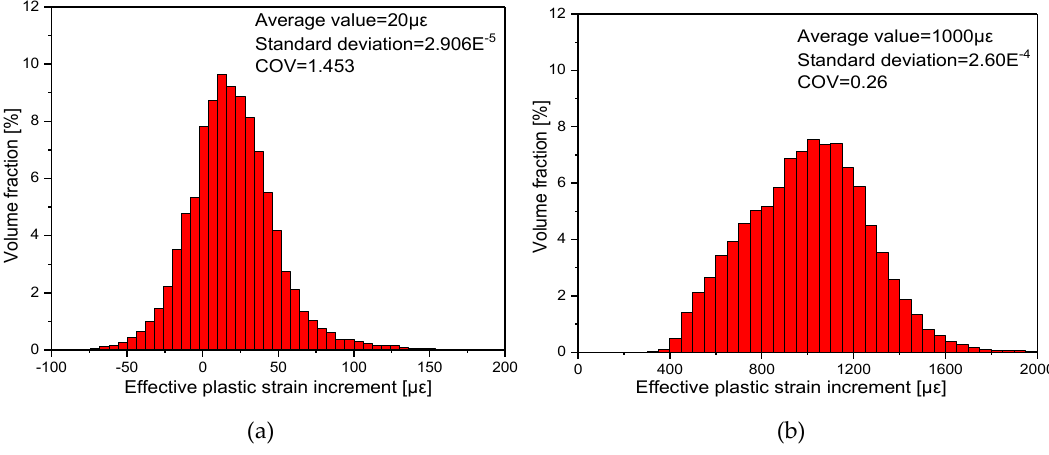
Figure 15. Statistical distribution of micro equivalent plastic strain increment with different offset strain value of 20 uε and 1000 uε along 180° reloading path at unloading point D-O D after 30 tension-compression cycles. ( a ) the offset strain 20 με; ( b ) the offset strain 1000 με.